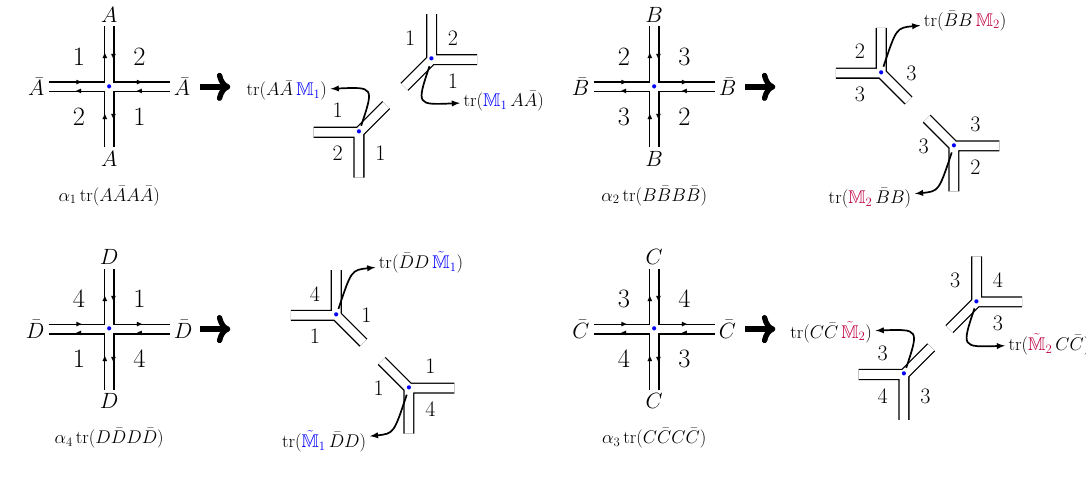
Figure 23 . Splitting vertices with couplings (cid:11)